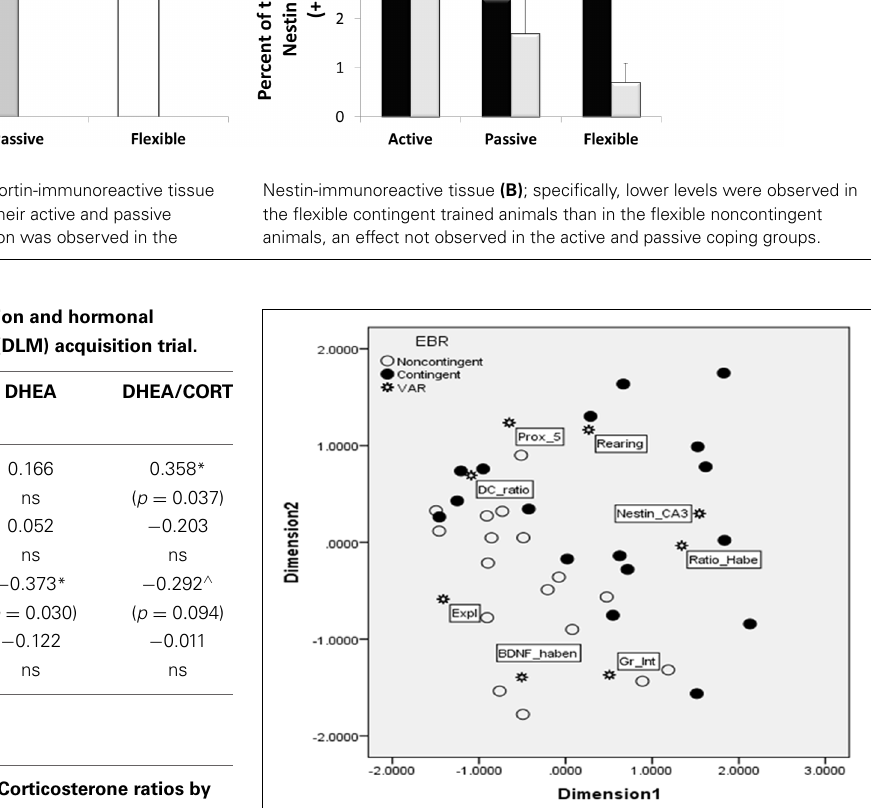
FIGURE 6 | Multidimensional scaling map exhibiting proximity of key variables for the contingent and noncontingent animals during the DLM probe trial. As indicated in Results, the stress value for MDS was 0.101, and R 2 = 0 . 956, thus indicating that the map was accurate and able to explain most of the variability. Two major clusters were clearly identified by the MDS, separated in the figure by a line. The lower quadrants represent noncontingent animals that displayed higher BDNF in the habenula (BDNF_haben), together with higher level of grooming interrupted (Gr_Int), and explorative behavior (Expl). The second group, in the upper quadrants, was characterized by contingent animals displaying higher neuron to glial cells ratio in the habenula (Ratio_Habe), lower nestin activation in the CA3 contingent flexible animals (Nestin_CA3), a higher DHEA/CORT ratio (DC_ratio), more time spent in proximity of the previously baited well #5 (Prox_5), and rearing